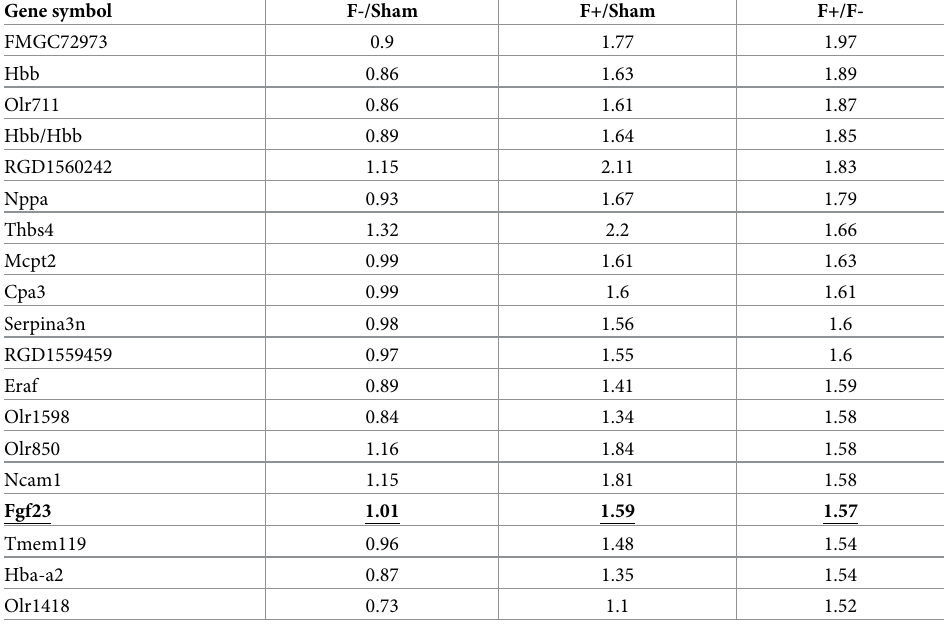
Table 2. Fold changes of gene expression levels.